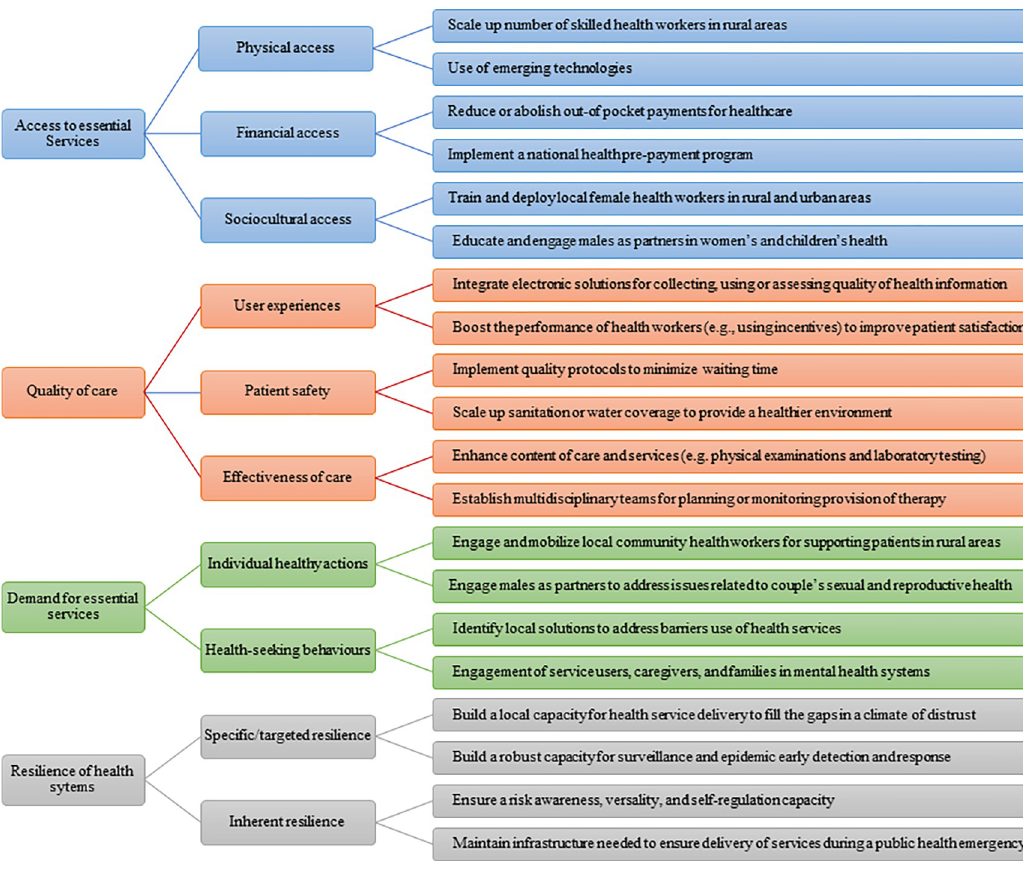
Fig 2. Examples of effective interventions that contributed to improving the functionality of health